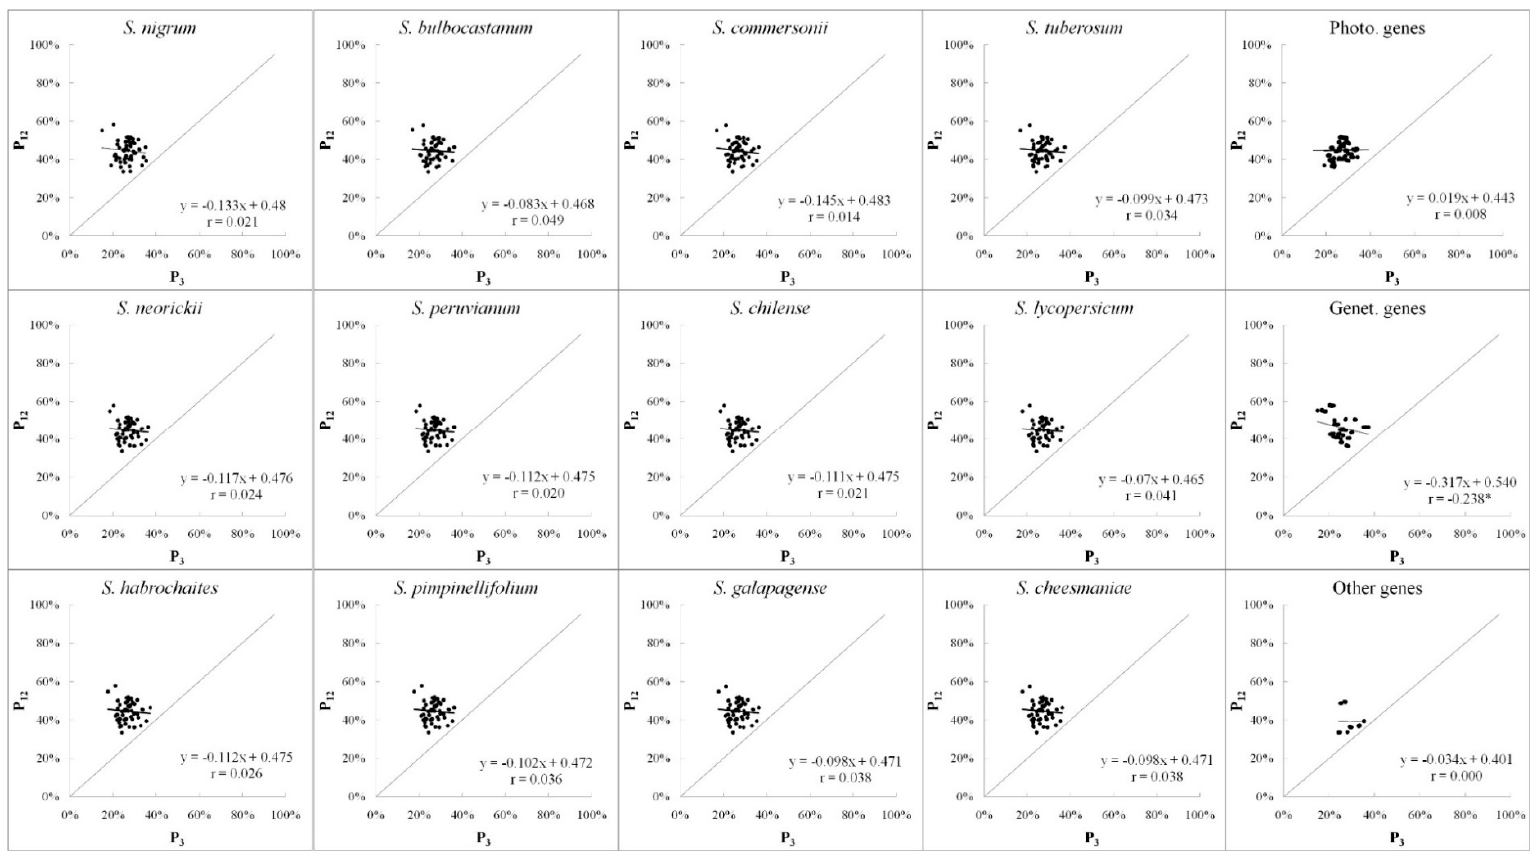
Figure 6. Neutrality plots of Solanum chloroplast genomes. Individual genes were plotted based on the mean GC content in the first and second codon position (P 12 ) versus the GC content of the third codon position (P 3 ). Regression lines and Spearman’s rank correlation coefficients (r) are shown, with the asterisk (*) denoting significance at the p < 0.01 level. Note that both the nearly horizontal regression curve and small correlation coefficient ( r = 0.008, p > 0.05) present a strong selective pressure for the photosynthesis related genes in Solanum chloroplast genomes. Whereas for the Genet-genes, its correlation coefficient of 0.238 with the significant correlation ( p < 0.01, marked with *) indicated that the mutational bias plays a more active role than the selective pressure in CUB for the Solanum chloroplast genetic system related genes.